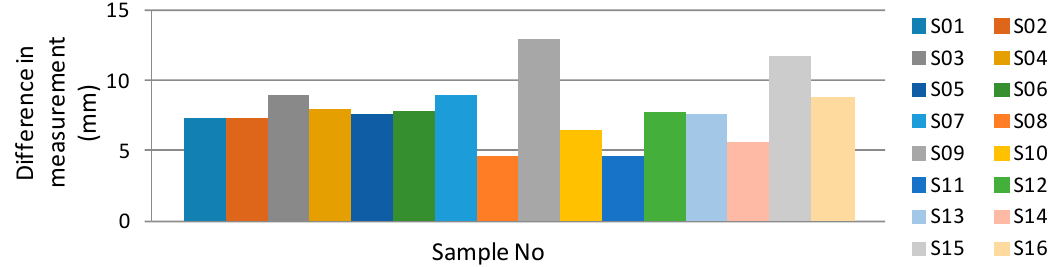
Figure 9. The difference between the measured values by image analysis and a laser distance meter for first measurement, i.e., maximum height of beer foam.